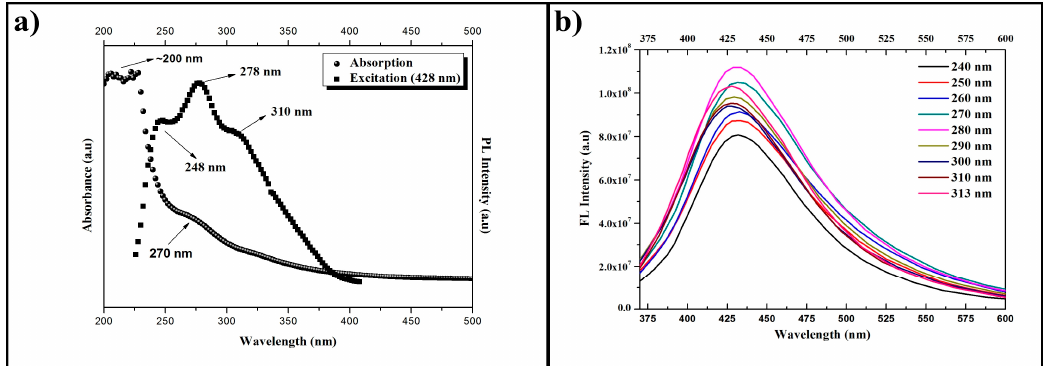
Figure 8. Absorption, excitation, and emission spectra for CQDs produced by Route II. ( a ) Absorption curve (spheres) and excitation curve (squares). ( b ) Emission curves (continuous lines) for different excitation wavelengths (increments of 10 nm).